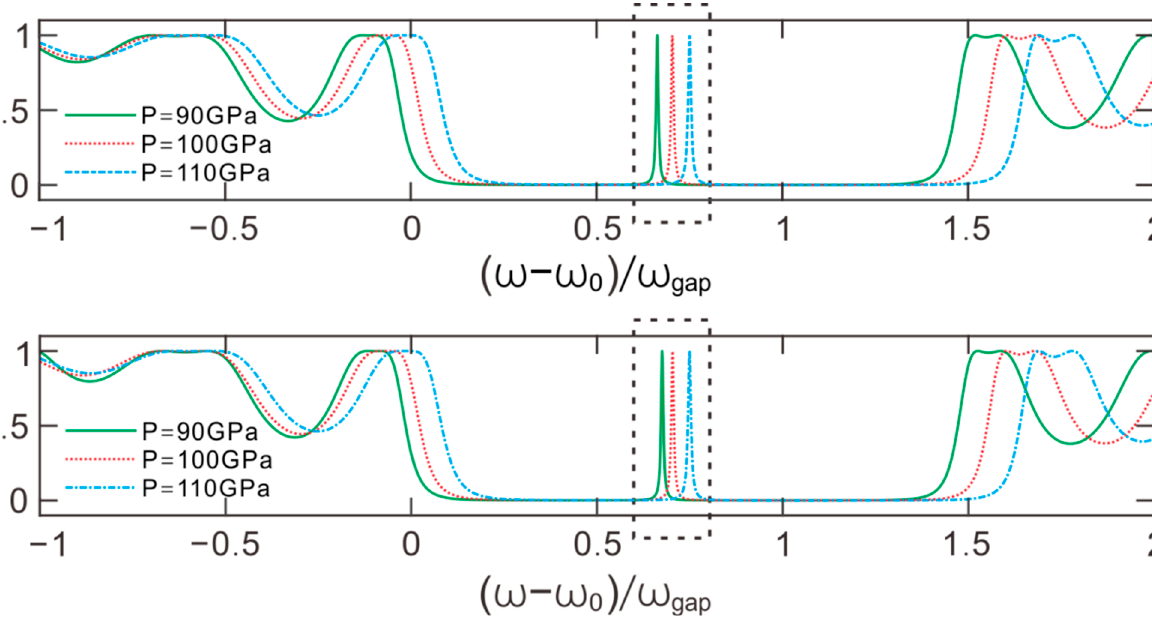
Figure 2. ( a , b ) Transmission spectra of light waves with different intensities of pressure for Te = 50 K and 100 K, respectively. The incident angle of light beam is set as θ = 45°. Periodic number of photonic crystal is set as N =